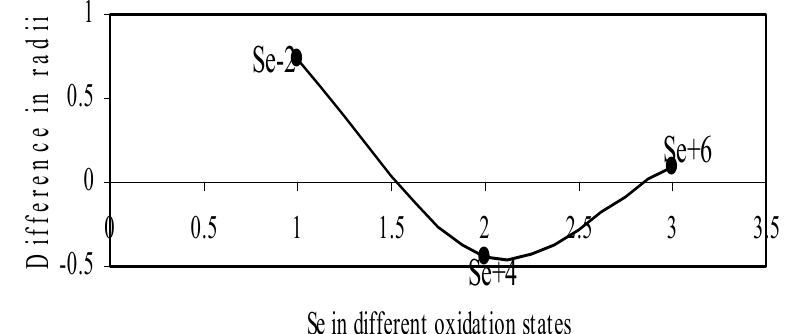
Figure 11. Plot of difference in experimental and theoretical radii of Se in different oxidation states.